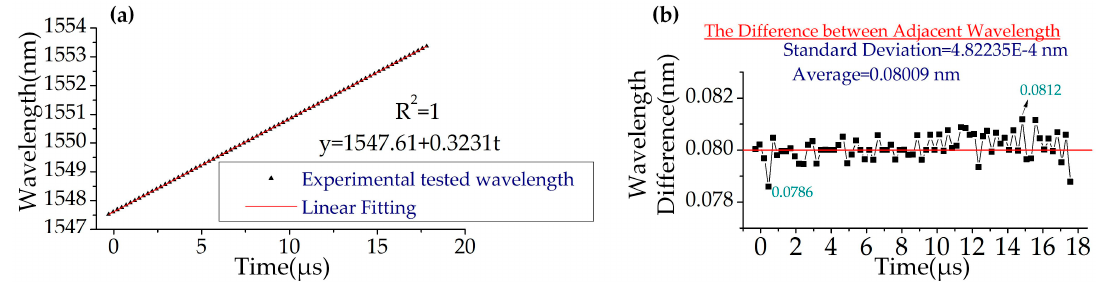
Figure 3. Further analysis of the linearity of the wavelength step-swept laser ( f RF = 10 GHz). ( a ) The wavelength-time mapping of the wavelength step-swept source. ( b ) The wavelength differences between adjacent pulses.